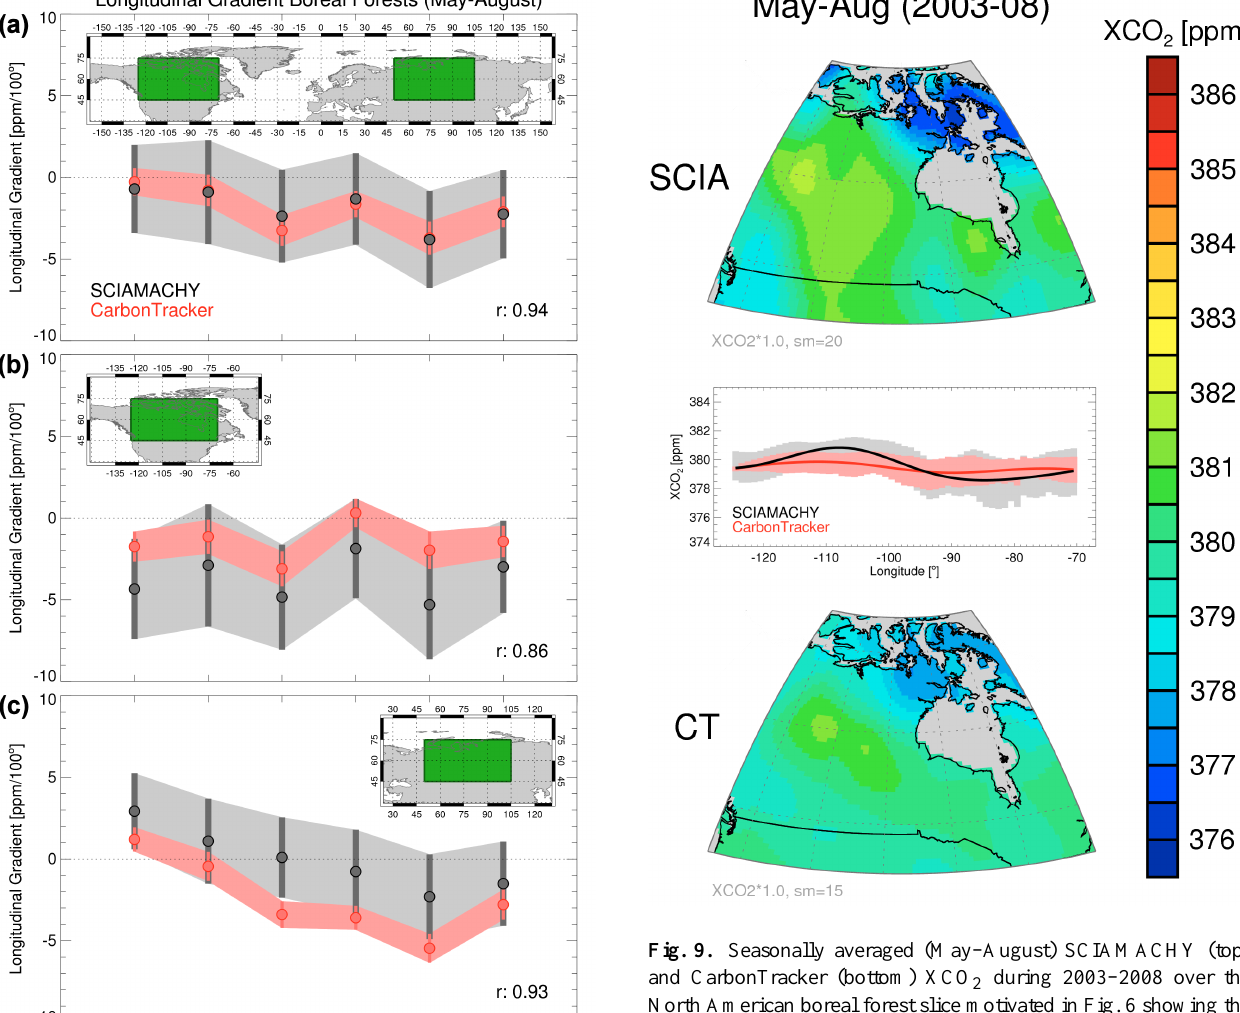
Fig. 7. Linear fits of the west-to-east longitudinal gradients of sea- sonally averaged (May–August) SCIAMACHY (black) and Car- bonTracker (red) XCO 2 during 2003–2008 for (a) North Amer- ica and (b) Russia weighted according to the standard deviations (shaded areas) of the meridional averages (0.5 ◦ bins). The associ- Fig. 8. Annual west-to-east longitudinal XCO 2 gradients from Fig. 8. Annual west-to-east longitudinal XCO 2 gradients from ated errors are derived from the square root of the covariance of the SCIAMACHY (black) and CarbonTracker (red) for boreal forests SCIAMACHY (black) and CarbonTracker (red) for boreal forests linear fit parameter. during the growing season to infer the corresponding carbon diox- during the growing season to infer the corresponding carbon diox- ide uptake of the terrestrial biosphere. The examined boreal forest ide uptake of the terrestrial biosphere. The examined boreal forest region is composed of the two equally sized regions in North Amer- region is composed of the two equally sized regions in North Amer- ica and Russia shown in green which was motivated in Fig. 6. The ica and Russia shown in green which was motivated in Fig. 6. The gradients and associated errors are illustrated for (a) the overall re- gradients and associated errors are illustrated for (a) the overall re- gion (mean of the partial regions) and (b) the North American and gion (mean of the partial regions) and (b) the North American and (c) Russian part individually. (c) Russian part individually.